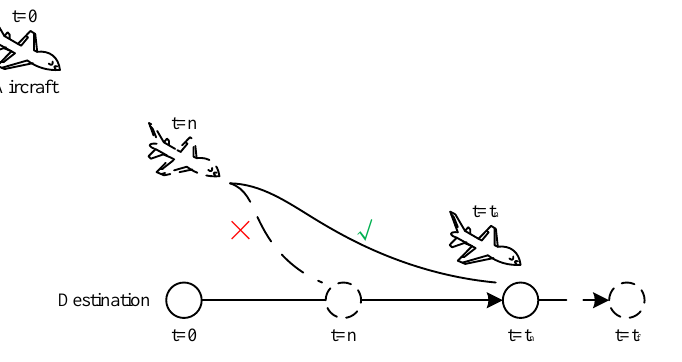
Figure 3. Destination position